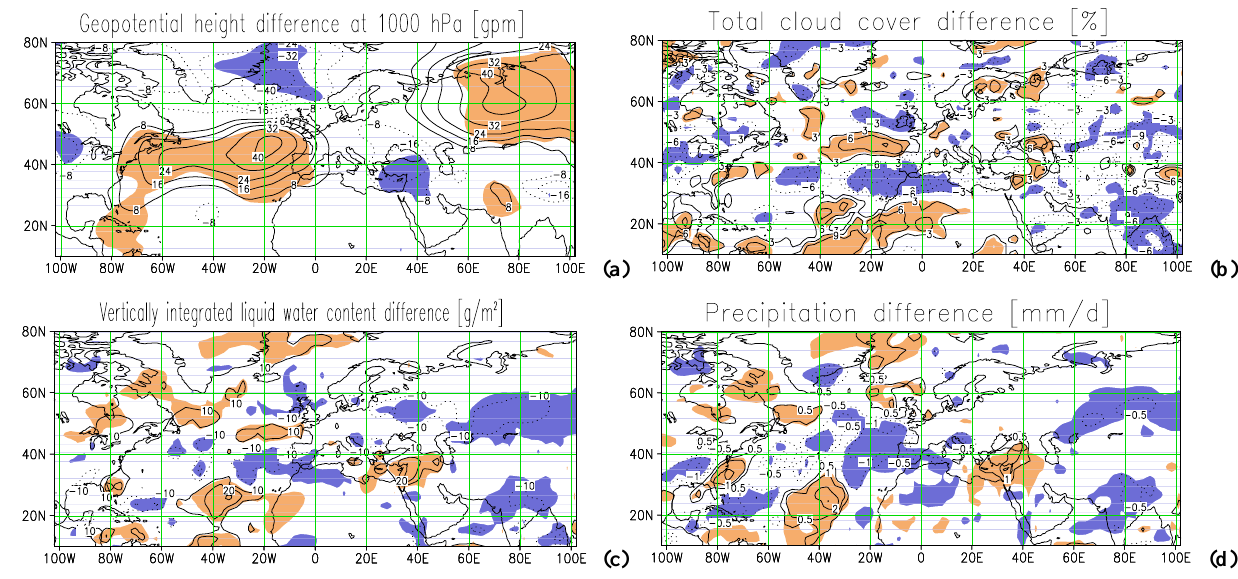
Fig. 9. Ozone anomaly response. The ozone anomaly response for mean January as difference between “anomaly” and “reference” experi- ment (regions inside a significance level of 80% are shaded) (a) For geopotential height at 1000 hPa, (b) For total cloud cover, (c) For vertical integrated liquid water, (d) For